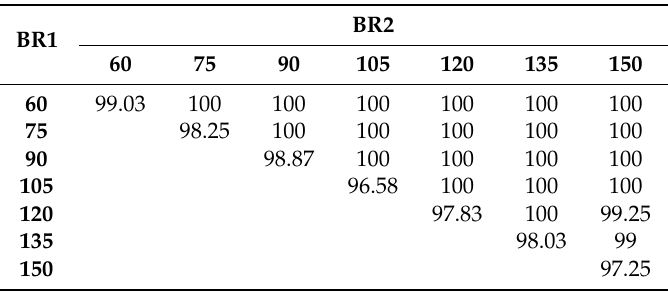
Table 3. Feature fusion Detection Accuracy—FAAC (%).